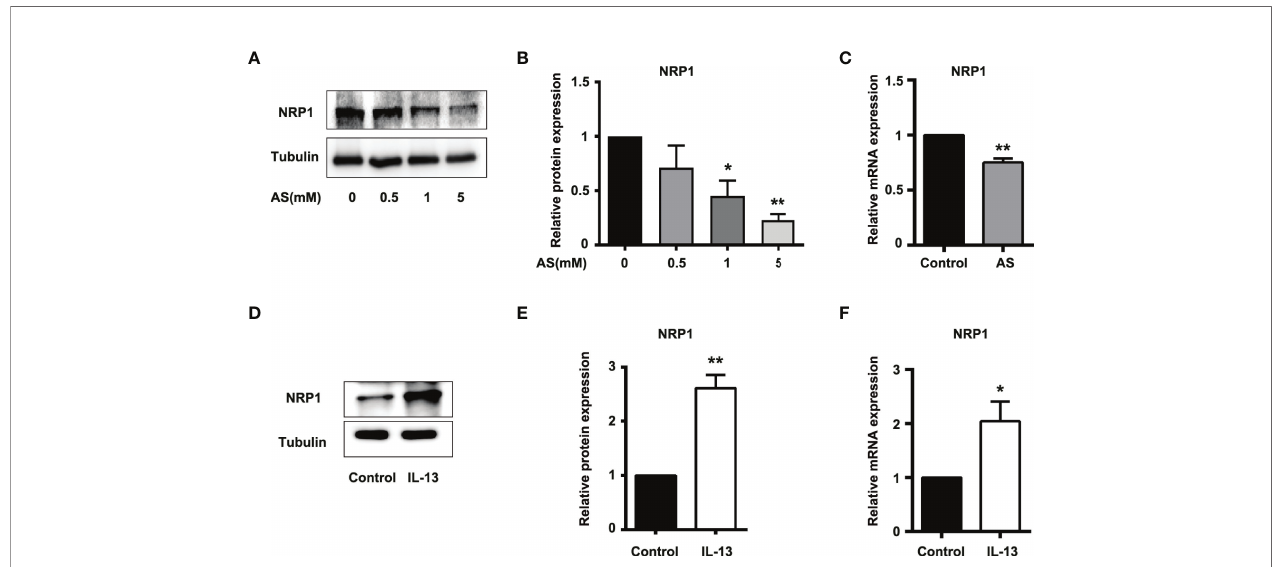
FIGURE 3 | STAT6-mediated NRP1 expression in HUVECs. (A) Expression of NRP1 was detected by western blotting in HUVECs treated with 0.5, 1, or 5 m M AS for 24 (h) (B) Relative NRP1 expression normalized with tubulin after AS treatment, n=3, * P <0.05 vs. control, ** P <0.01 vs. control. (C) Expression of NRP1 was detected by qPCR in HUVECs treated with AS (1 m M) for 24 h, n=3, ** P <0.01 vs. control. (D) Expression of NRP1 was detected by western blotting in HUVECs treated with IL-13 (50 ng/mL) for 24 (h) (E) Relative NRP1 expression normalized with tubulin after IL-13 treatment, n=3, * P <0.05 vs. control, ** P <0.01 vs. control. (F) Expression of NRP1 was detected by qPCR in HUVECs treated with IL-13 (50 ng/mL) for 24 h, n=3, ** P <0.01 vs.